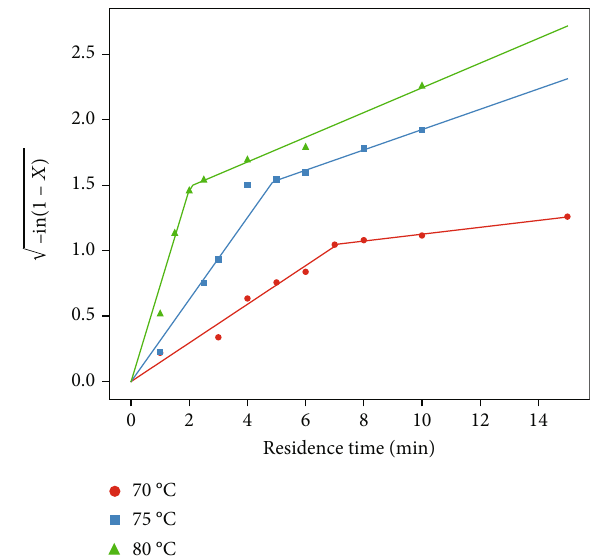
Figure 4: Piecewise linear fi tting at di ff erent temperatures. Table 2: The regression coe ffi cients and r -square statistics. Temperatures ( ° C)